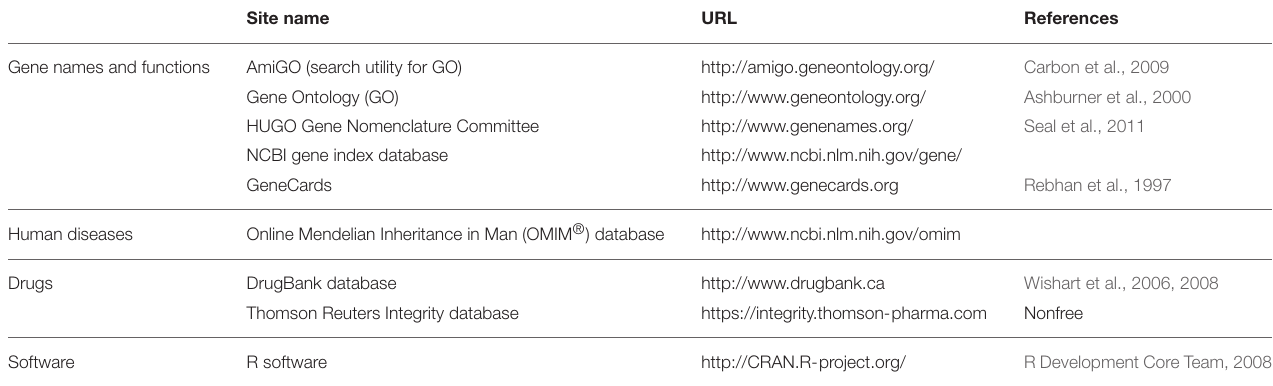
TABLE 3 | Overview on data sources and computational tools used for the present data science approach to drug repurposing from knowledge about the functions of genes related to insensitivity to pain in humans.